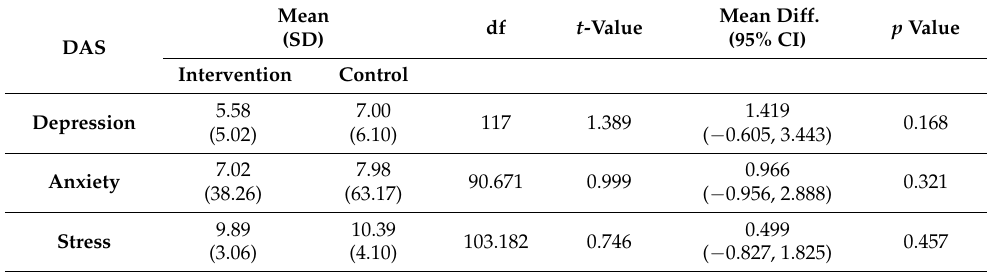
Table 2. Baseline comparison of depression, anxiety, and stress scores.